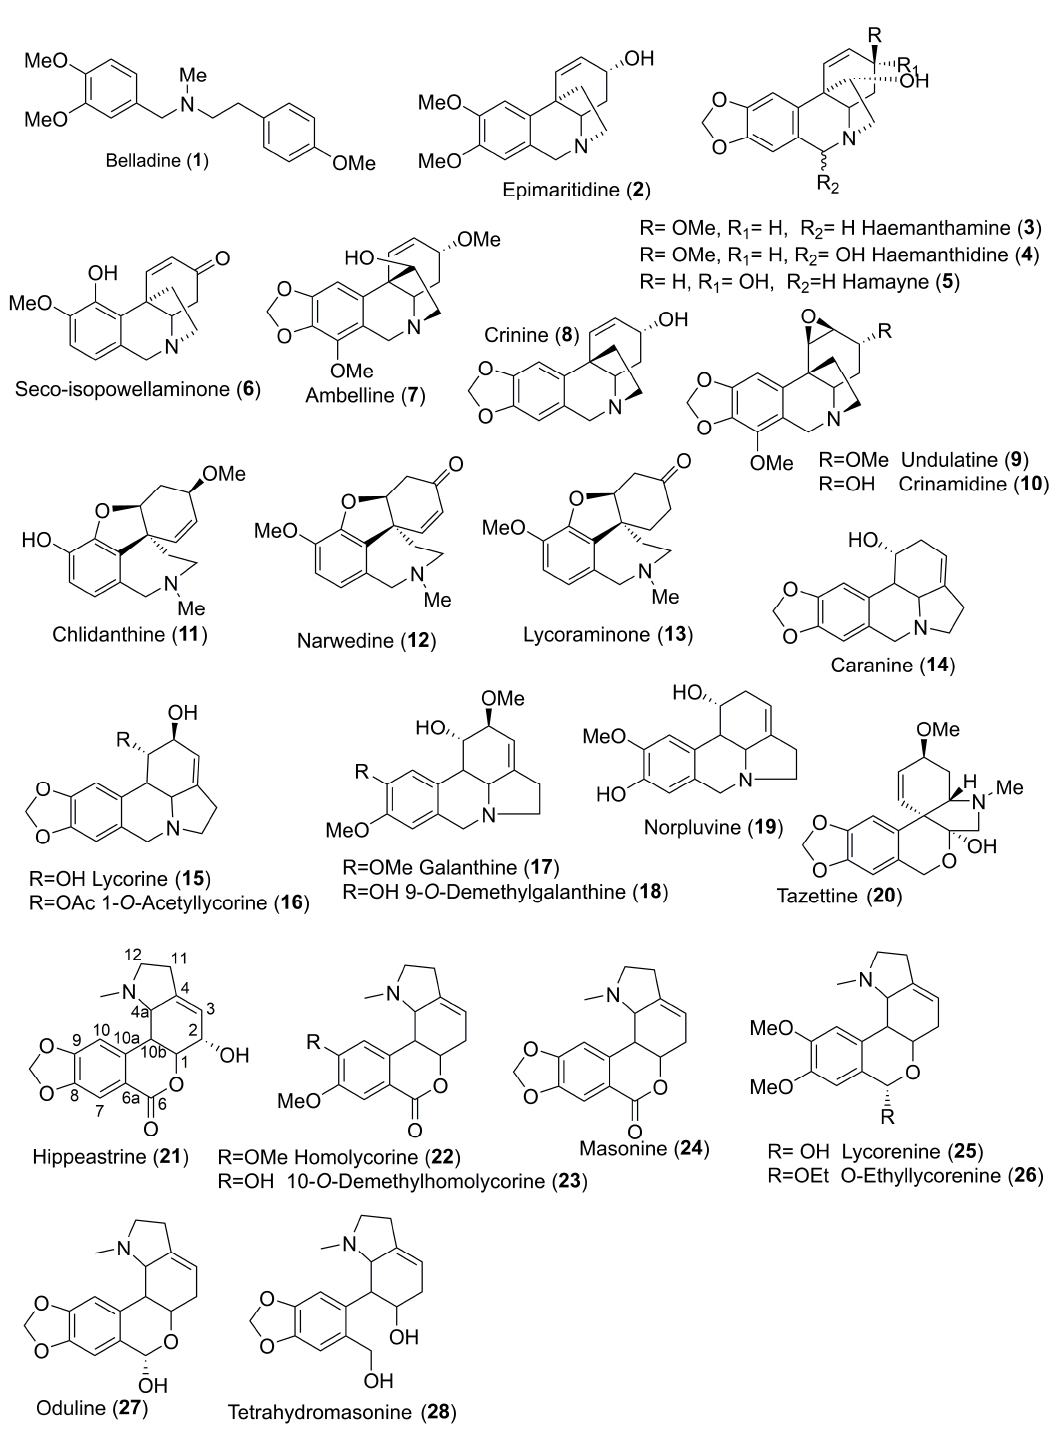
Figure 1. Structures of the studied Amaryllidaceae alkaloids.